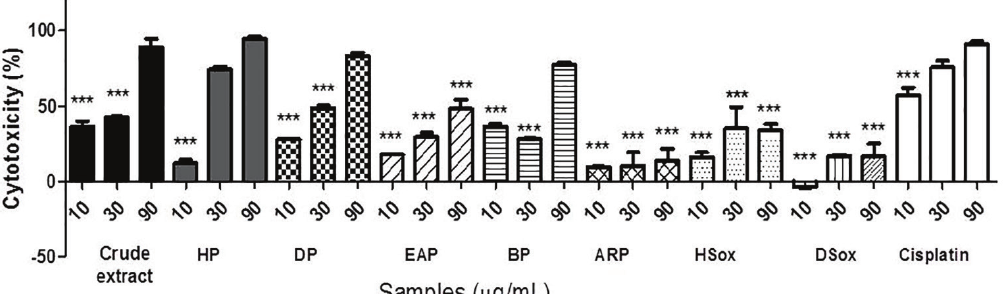
FIGURE 7 - Comparative cytotoxic activities in percentage values for the crude extract and partitions (hexane, dichloromethane, ethyl acetate, butanol, aqueous residue) from maceration; Soxhlet hexane (HSox) and dichloromethane (DSox) extracts obtained from P. mucronata and cisplatin against the K562 cell line, in three different concentrations (90, 30 and 10 μg.mL -1 ). The results express the average of three independent experiments in triplicate. Statistical was performed by one-way ANOVA followed by Tukey’s t-test (p<0.05). The analysis was comparative one by one with all concentrations to the major concentration of cisplatin (90 μg.mL -1